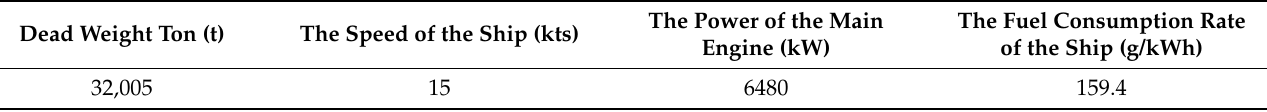
Table 1. Detailed parameters of the experimental ship.